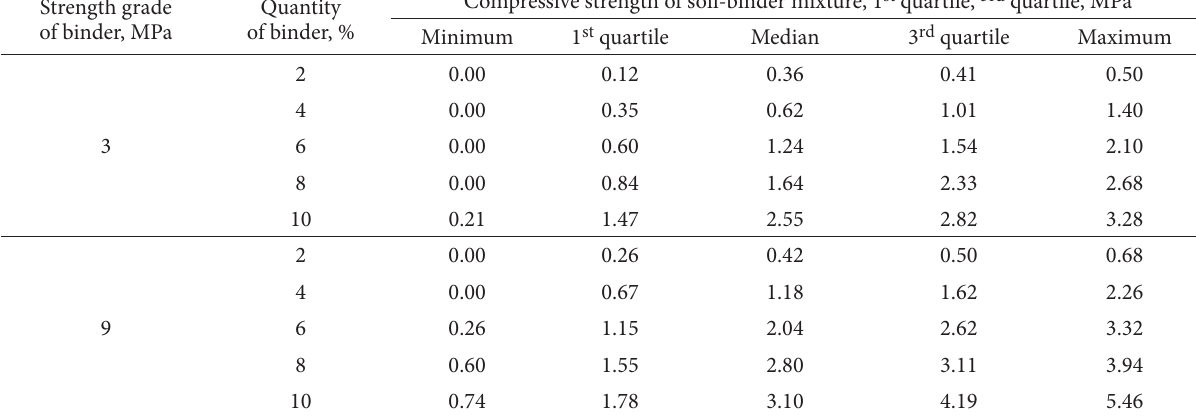
Table 1. Statistical parameters for the compressive strength R c of soil-binder mixtures after hardening for 28 days, depending on configuration of quantity of hydraulic binder added and strength grade of binder Strength grade of binder, MPa